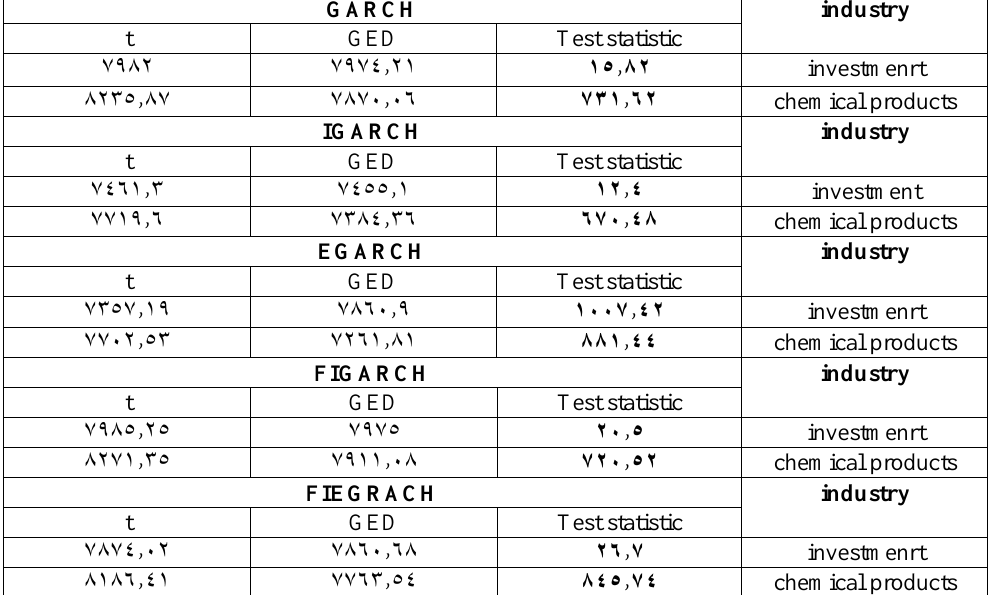
Table 11. Results of the Garcia–Perron likelihood ratio test in GARCH models without